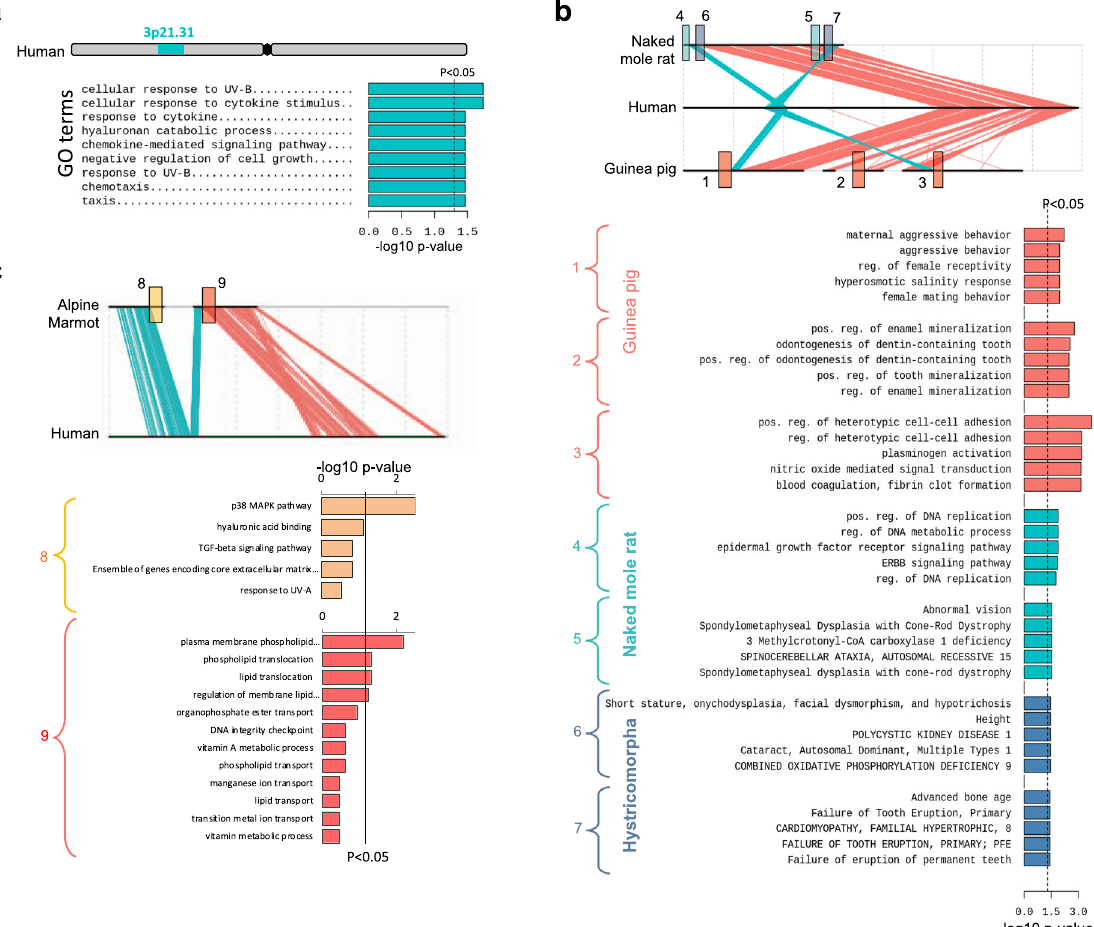
Fig. 7 Function of genes located within 3p21.31 and near the breakpoints in hystrico- and sciuromorphs. a Enrichment of gene ontology terms in 3p21.31 locus. b , c Enrichment of gene ontology terms in regions near various breakpoints in NMR, guinea pig, and alpine marmot. The breakpoint regions 1 – 3 are speci fi c to guinea pig. Regions 4 – 5 are speci fi c to NMR, 6 – 7 are common to both the hystricomorphs, and 8 – 9 are speci fi c to Aalpine marmot. All gene ontology analyses were performed using ToppGene suite with P-value correction through Benjamini – Hochberg